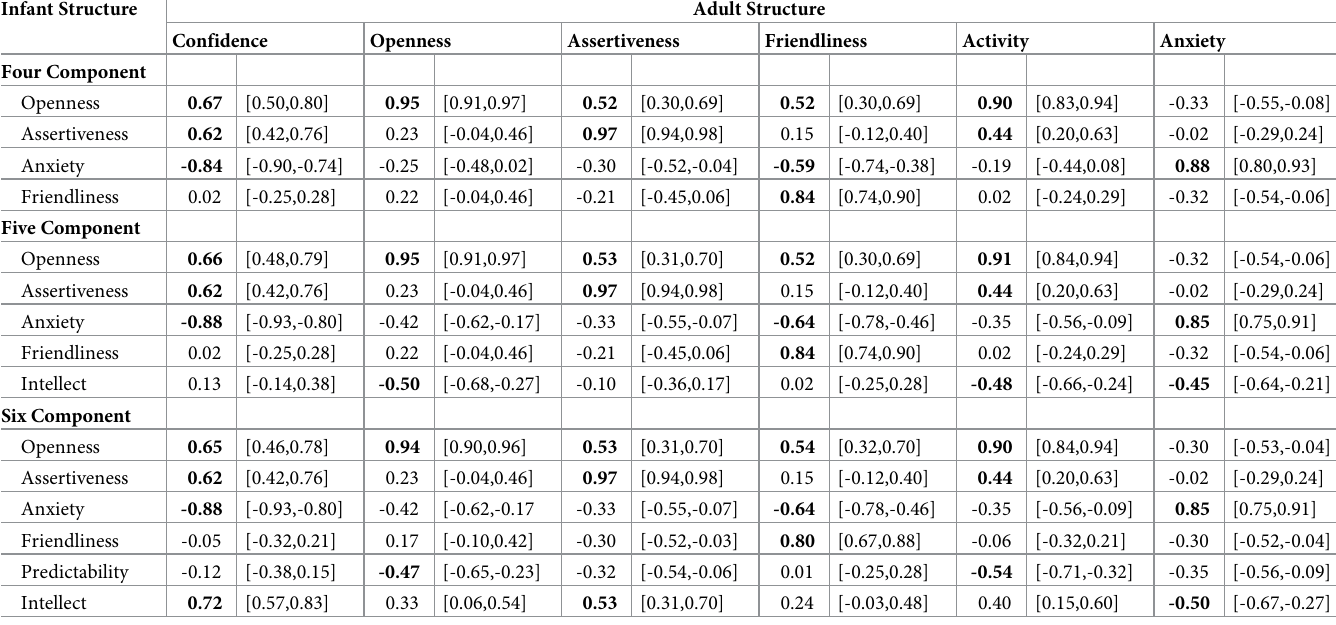
Table 3. Pearson correlations for infant personality components based on the six component adult personality structure (from [53]). Infant